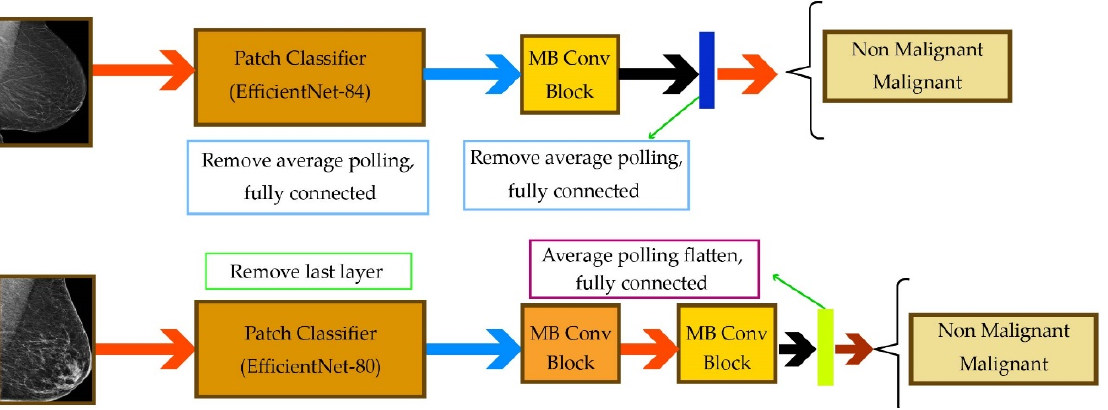
Figure 5. Diagrams of the single-view classifier for the “CV test” ( top ) and “OD test” ( bottom ).